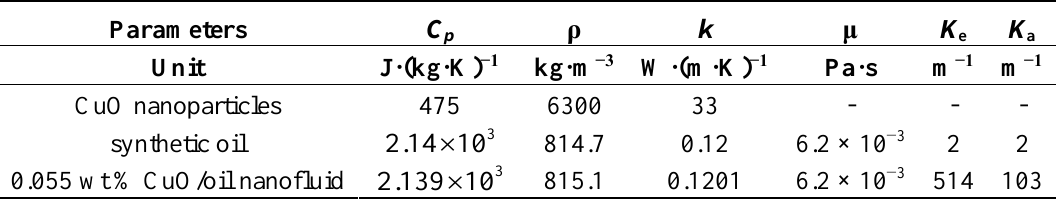
Table 1. Physical properties of the synthetic oil and nanofluid. Parameters